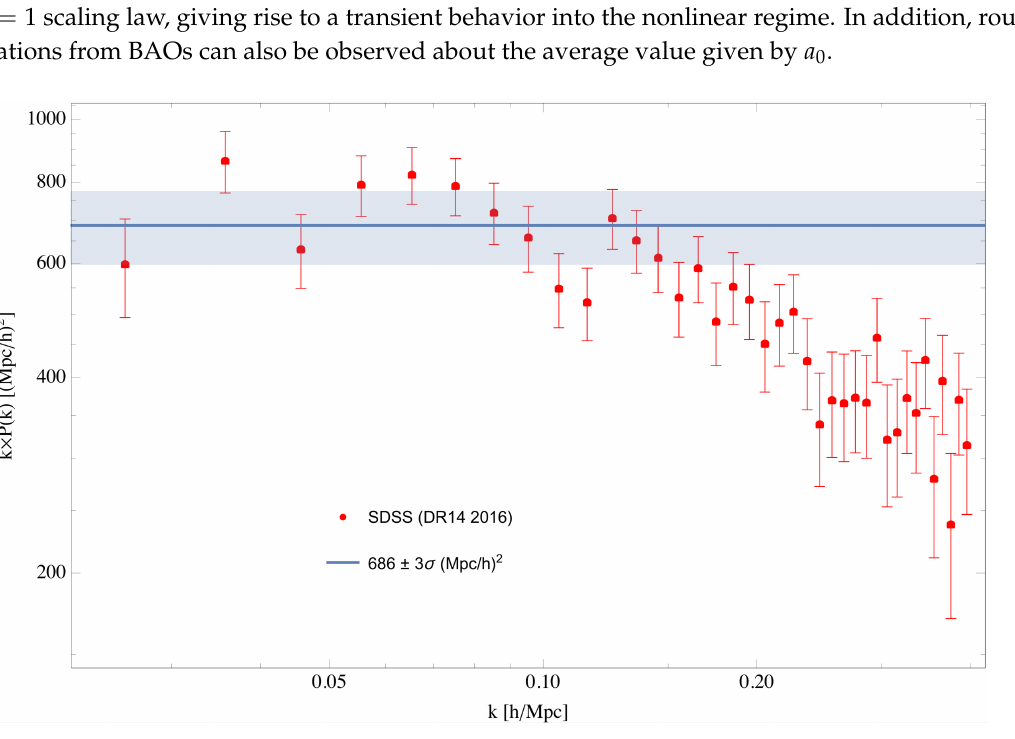
Figure 1. The observed galaxy power spectrum in k × P ( k ) versus wavenumber k . The data points are taken from the Sloan Digital Sky Survey (SDSS) collaboration’s 14th Data Release (DR14) [70]. Quantum gravity predicts that in the linear regime ( k ∼ < 0.15 h Mpc − 1 ), as r → ∞ (or k → 0), P ( k ) should approach a scale-invariant spectrum with ν = 1/3 (i.e., s = 1), as in Equation (19). In other words, k × P ( k ) should approach a constant. The solid line represents the asymptotic value of the s = 1 spectrum, with a one-parameter fit for the amplitude in Equation(19) giving a 0 (cid:39) 686 ( Mpc/h ) 2 . The gray bands represent a 3 σ ( ∼± 15 %) variance to the fit. It can be seen that, below k < 0.15 h Mpc − 1 , the data generally approach a constant of approximately a 0 ∼ 686 ( Mpc/h ) 2 , but beyond k > 0.15 h Mpc − 1 the data shows a transient region where the points deviate from the linear scaling, due to the relevant correlation function probing distances smaller than the linear scaling